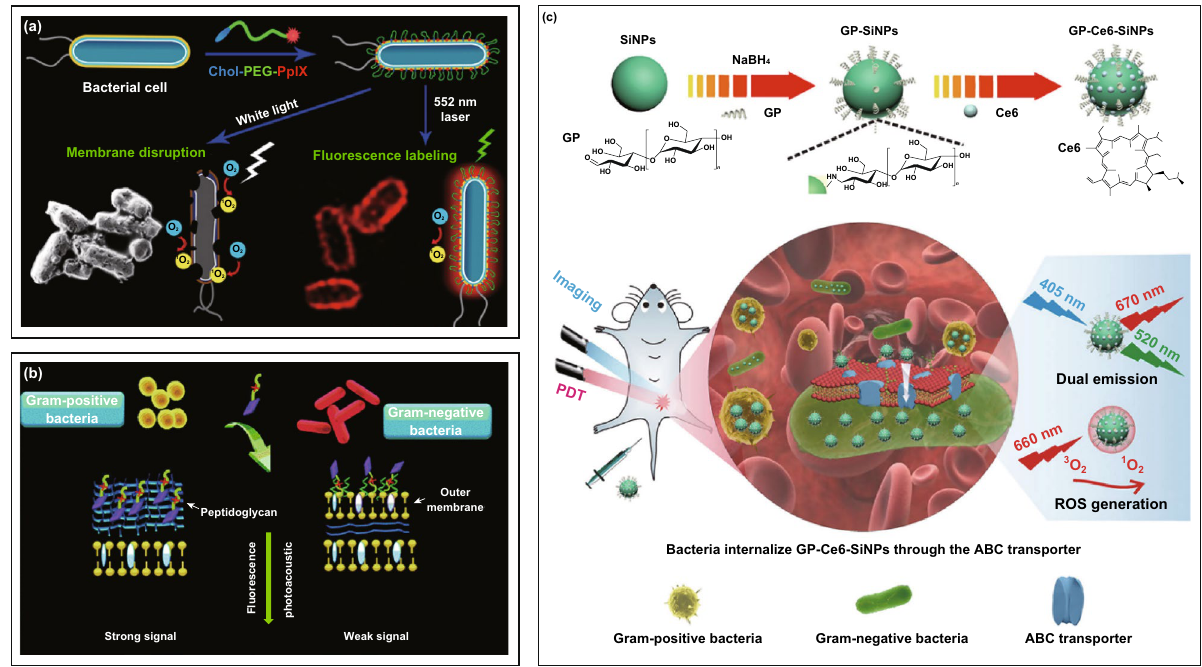
Fig. 3 a Representation of aPDT-mediated labeling and killing of Escherichia coli ( E. coli ) by cholesterol-modified PpIX (Chol-PEG-PpIX) upon light irradiation [46]. Copyright 2017 American Chemical Society. b Schematic of polyarginine-purpurin conjugates for different photo- dynamic inactivation and imaging on Gram-positive and Gram-negative bacteria [48]. Copyright 2016 Royal Society of Chemistry. c Design of multifunctional nanoplatform with multiple emission signals for effective detection and photodynamic treatment of bacterial infections [49]. Copyright 2019 Creative